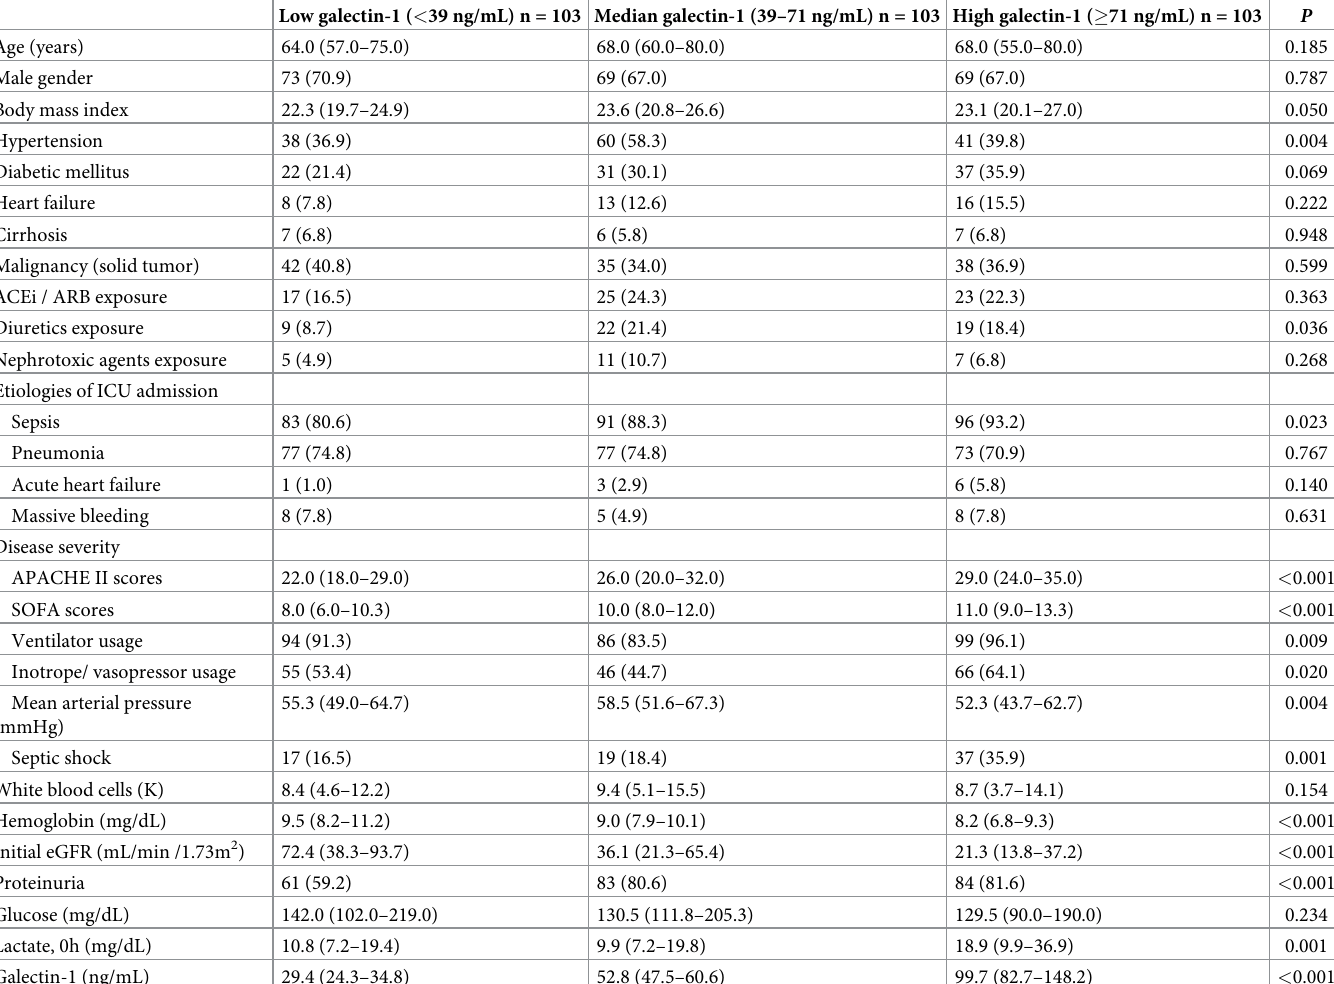
Table 1. Baseline characteristics of critically ill patients grouped by serum galectin-1